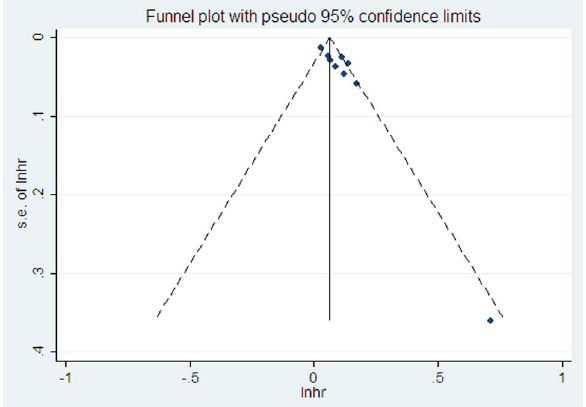
Figure 4. Funnel plots for the assessment of potential publication bias in studies used to analyze RDW for predicting ACM in HF patients. Each solid rectangle represents an eligible study in the meta-analysis. The center line indicates the summarized HR. RDW, red blood cell distribution width; HF, heart failure; ACM, all-cause mortality.